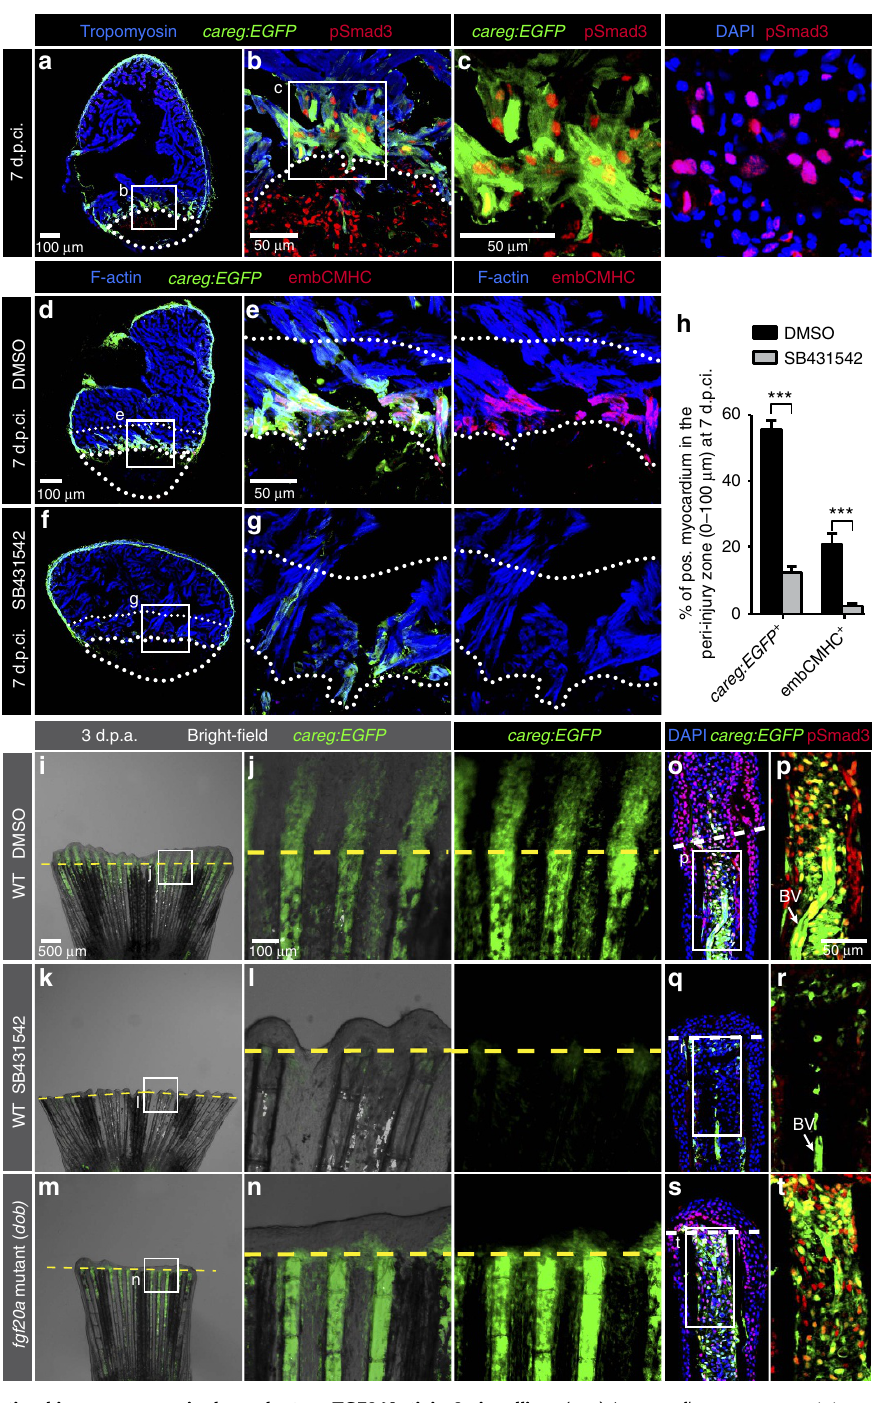
Figure 5 | The regeneration biosensor careg is dependent on TGF b /Activin- b signalling. ( a – c ) Immunofluorescence staining of careg:EGFP ventricle at 7 d.p.ci. with antibodies against GFP (green), pSmad3 (red) and Tropomyosin (blue) revealed the presence of TGF b /Activin- b -activated cells in the careg:EGFP -expressing tissue. N ¼ 6. ( d – g ) careg:EGFP heart sections at 7 d.p.ci. treated with 0.1% DMSO or 20 m M SB431542, an inhibitor of TGF b type